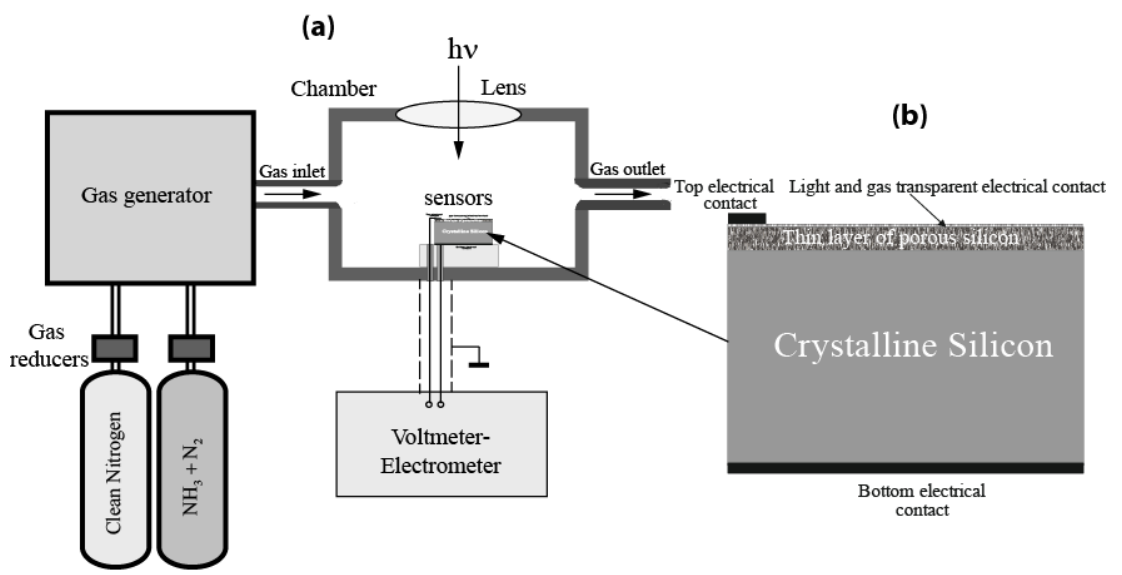
Figure 1. (a) Experimental setup and (b) cross-section of Photo-EMF sensors